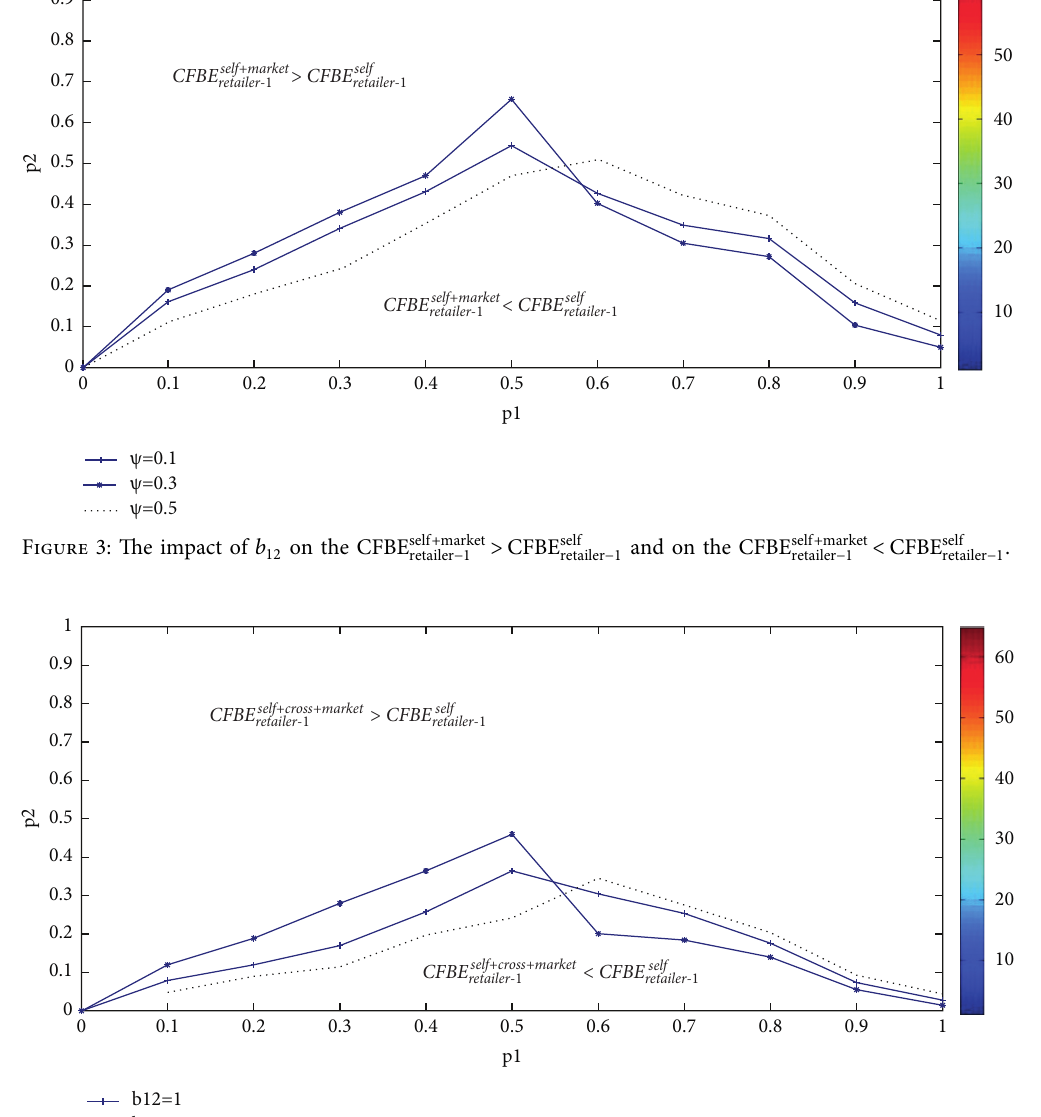
> CFBE self and on the CFBE self + cross + market retailer − 1 ∈ 0 , 1 { } 12 b